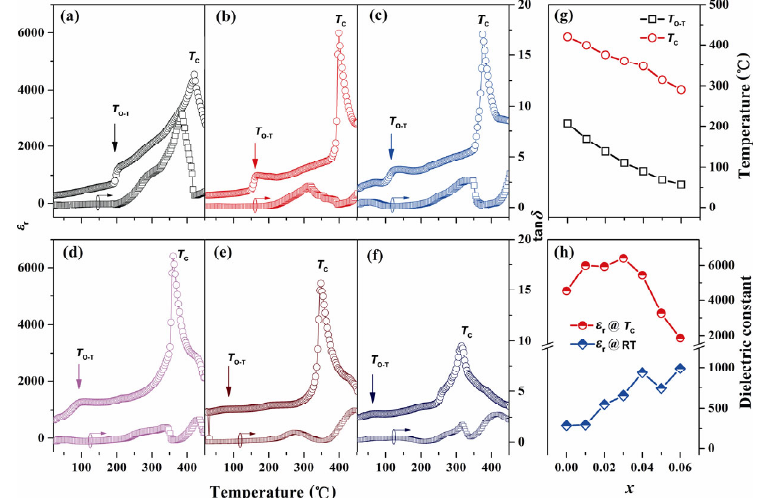
Fig. 5 Temperature dependence of dielectric constant ( KNN– x BLZ ceramics: (a) x = 0, (b) x = 0.01, (c) x = 0.02, (d) x = 0.03, (e) x = 0.04, (f) x = 0.05, (g) and ; (h) dielectric constants at room temperature and .